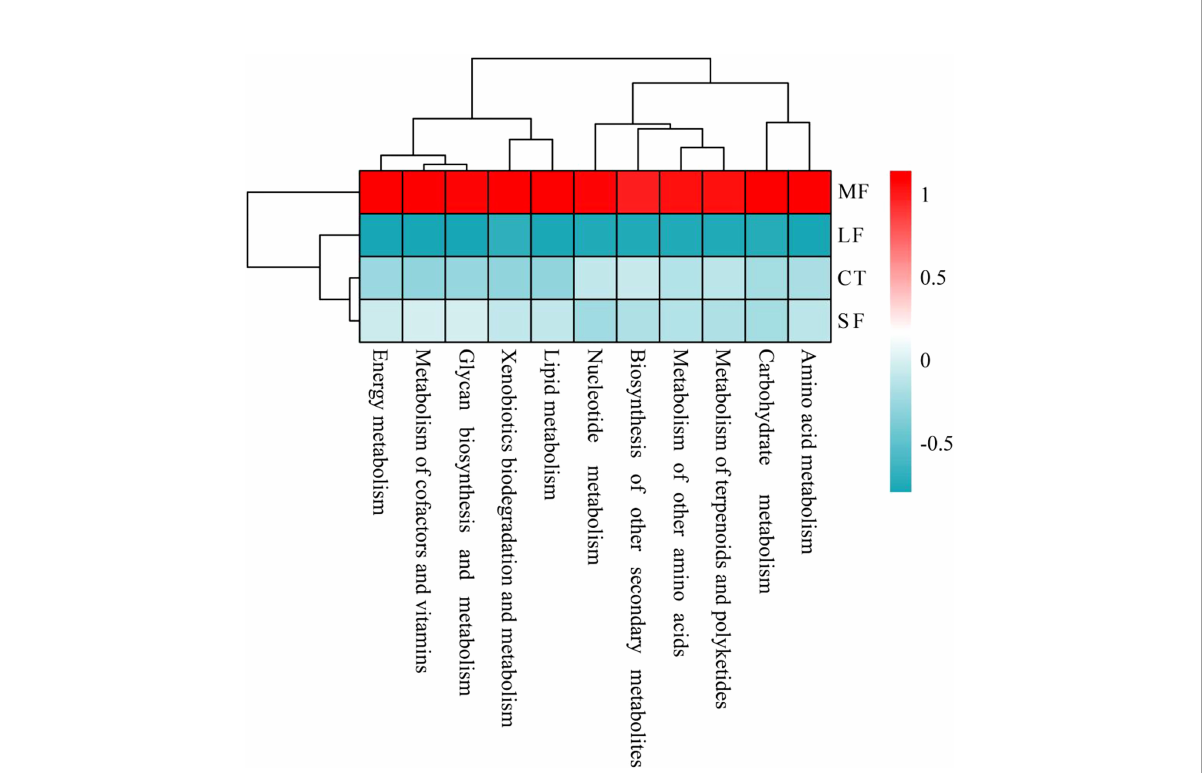
FIGURE 10 Cluster heat map showing Pearson correlations between pathways associated with different degrees of DTF (28°C, 28 ± 2°C, 28 ± 4°C, 28 ± 6° C) and gut microbial metabolism in juvenile crabs, with red representing positive correlations and cyan representing negative correlations.